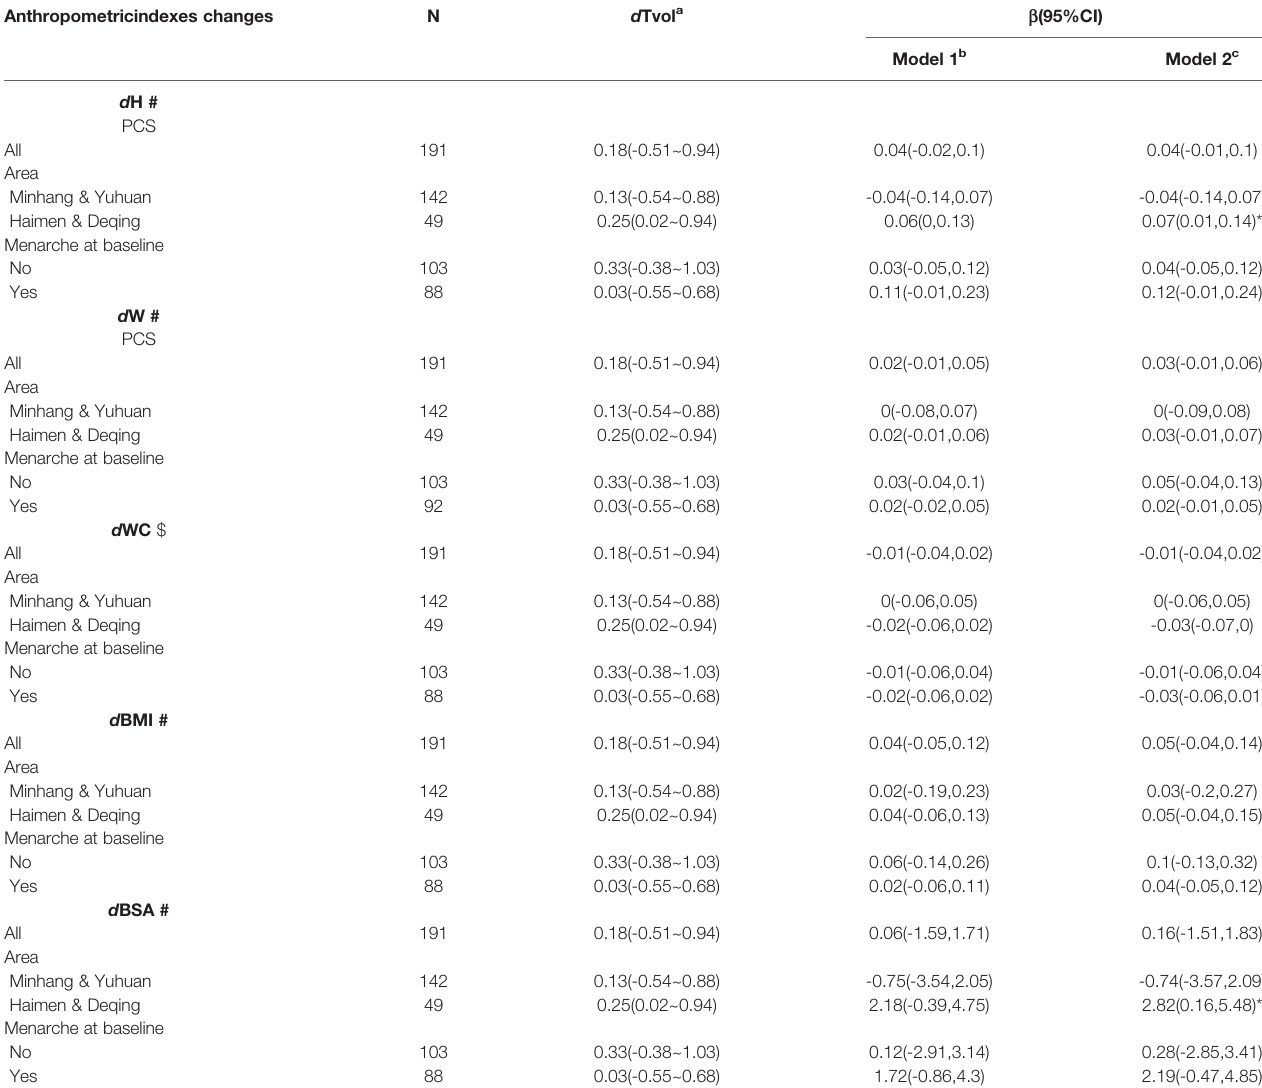
TABLE 2 | Regression coef fi cients ( b s) and 95% con fi dence intervals (95% CIs) for Tvol changes with anthropometric indexes changes by multiple linear regression models in 11 to 12-year-old group. Anthropometricindexes